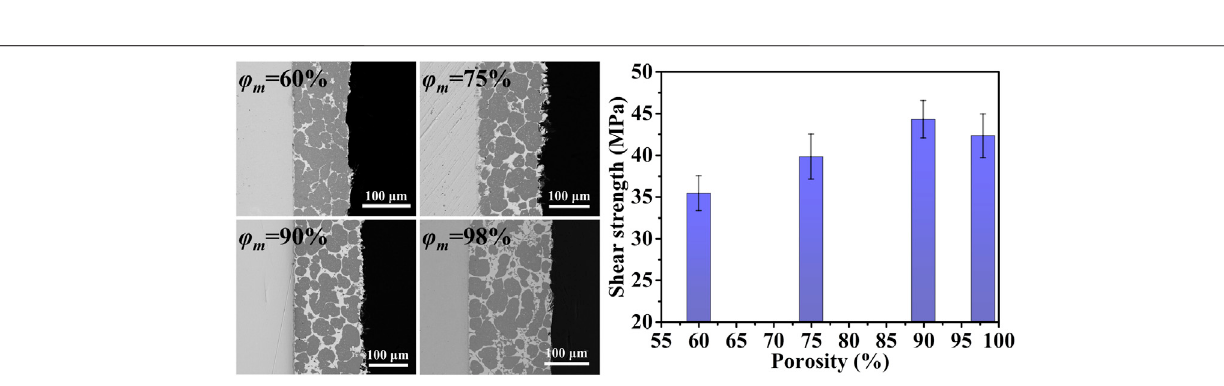
Frontiers in Materials |